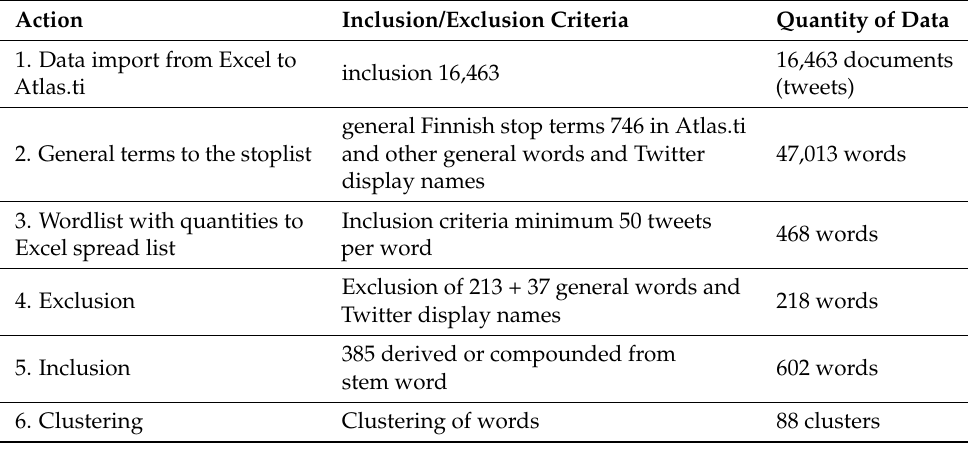
Table 3. The process of word count analysis in Atlas.ti and the spreadsheet.